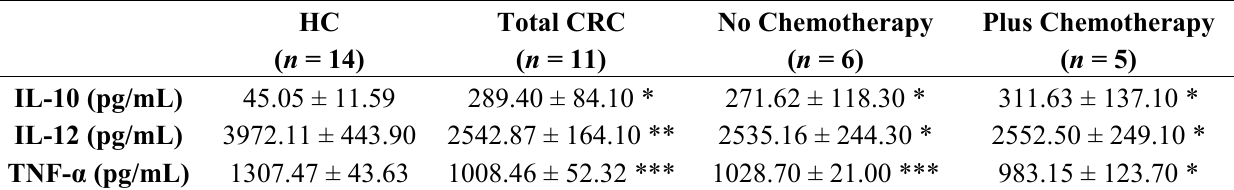
Table 3. Cytokine determination: a comparison of total, chemotherapy-treated and untreated patients and healthy controls at the third